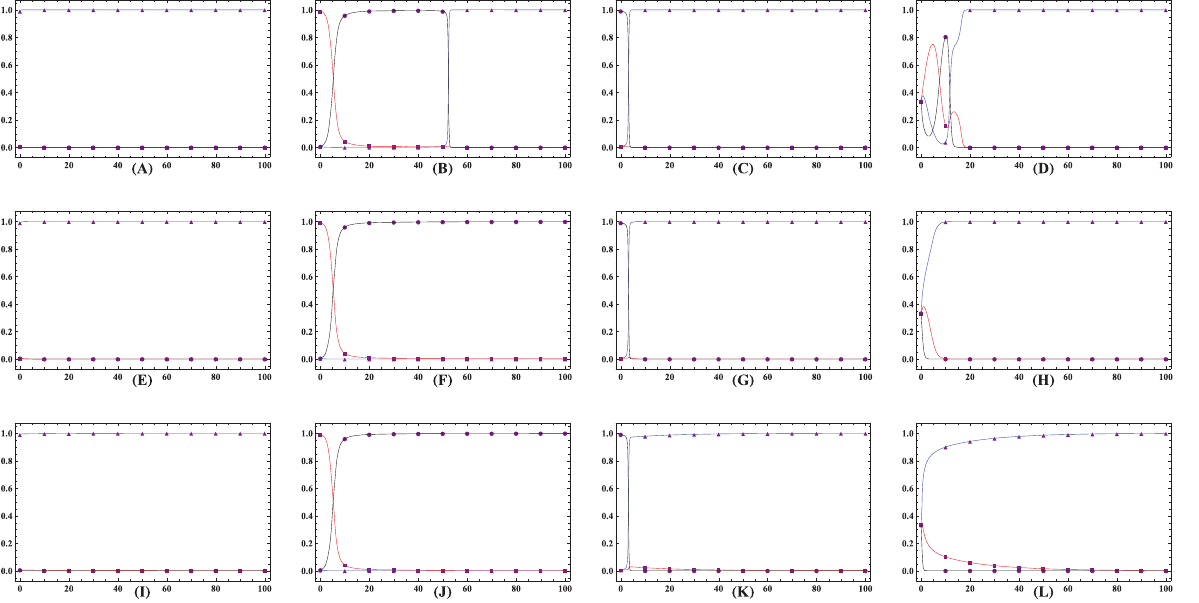
Figure 4. Population dynamics whenever cooperators defectors, and loners compete to survive. The lines embedded with solid triangle, square, and circle represent the evolutionary trajectories of cooperators, defectors and loners, respectively. For r ~ 10 , cooperators pervade into the whole population in the inverse sigmoidally and linearly dependent pattern, while loners completely dominate in the sigmoidally pattern, when defectors abound at the starting point. In the other typical cases, cooperators uniformly take over the whole population, though sometimes the evolutionary processes are different. Parameters N ~ 10 , r ~ 10 . Upper row m ~{ 0 : 4 , middle row m ~ 0 , and low row m ~ 10 .